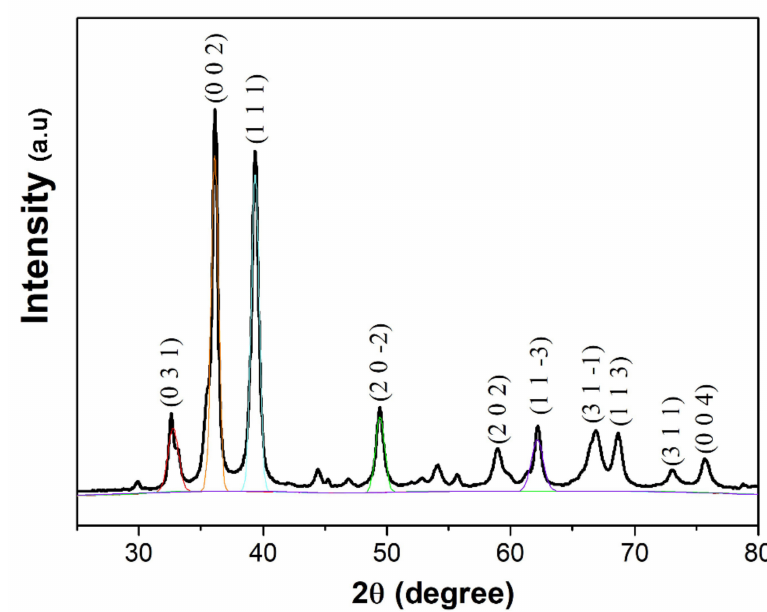
Figure 2. X-ray diffractogram of M. calabura derived CuO nanoparticles.